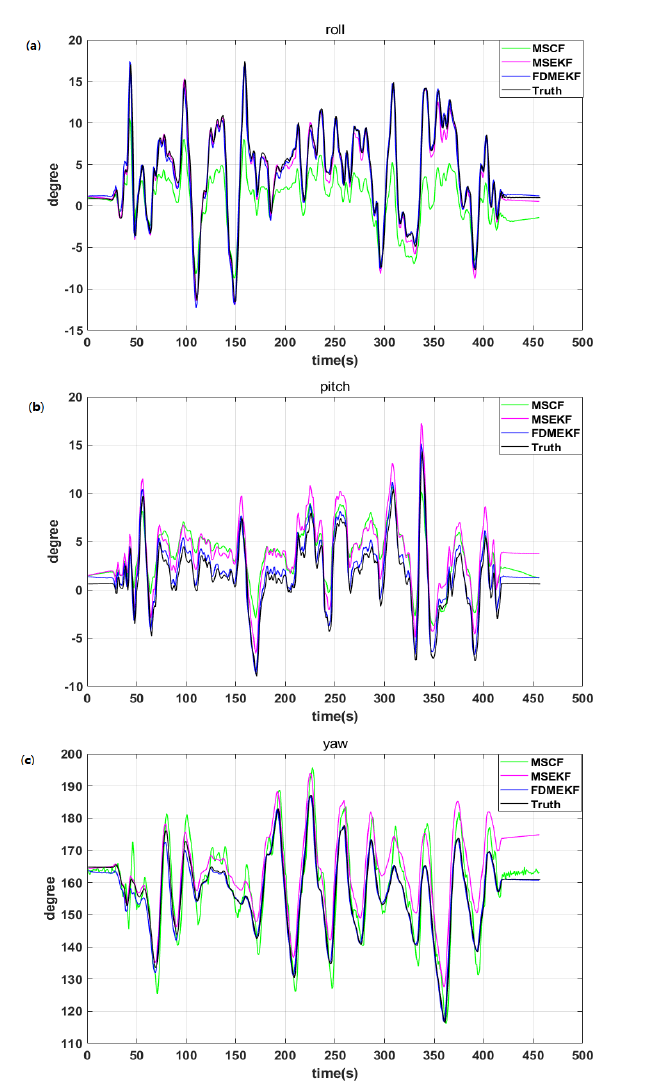
Figure 15. The attitude the UAV in flight. ( a ) the roll of the UAV; ( b ) the pitch of the UAV; ( c ) the yaw of the UAV. Table 4. MAE, STD, and RMSE of the attitude achieved by MSCF, MSEKF, and FDMEKF for the experimental